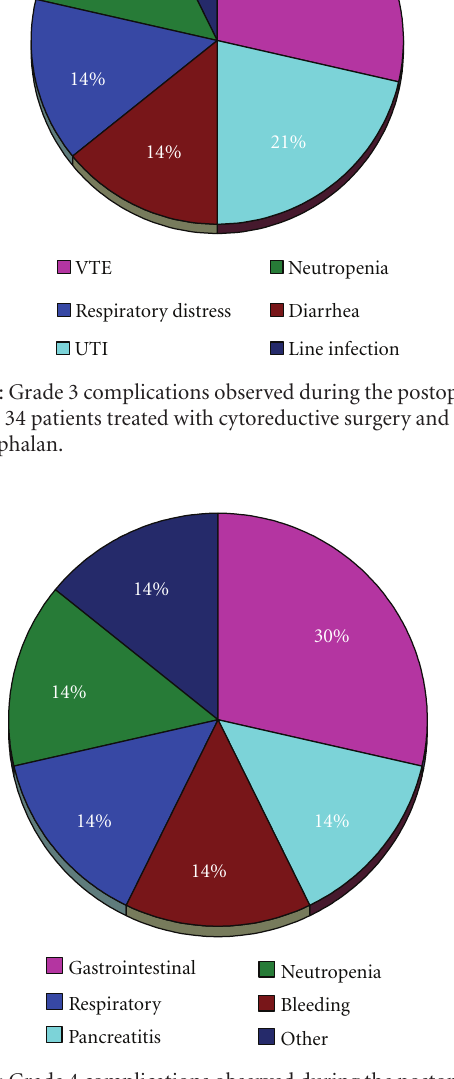
Figure 2: Grade 4 complications observed during the postoperative period in 34 patients treated with cytoreductive surgery and HIPEC with melphalan.